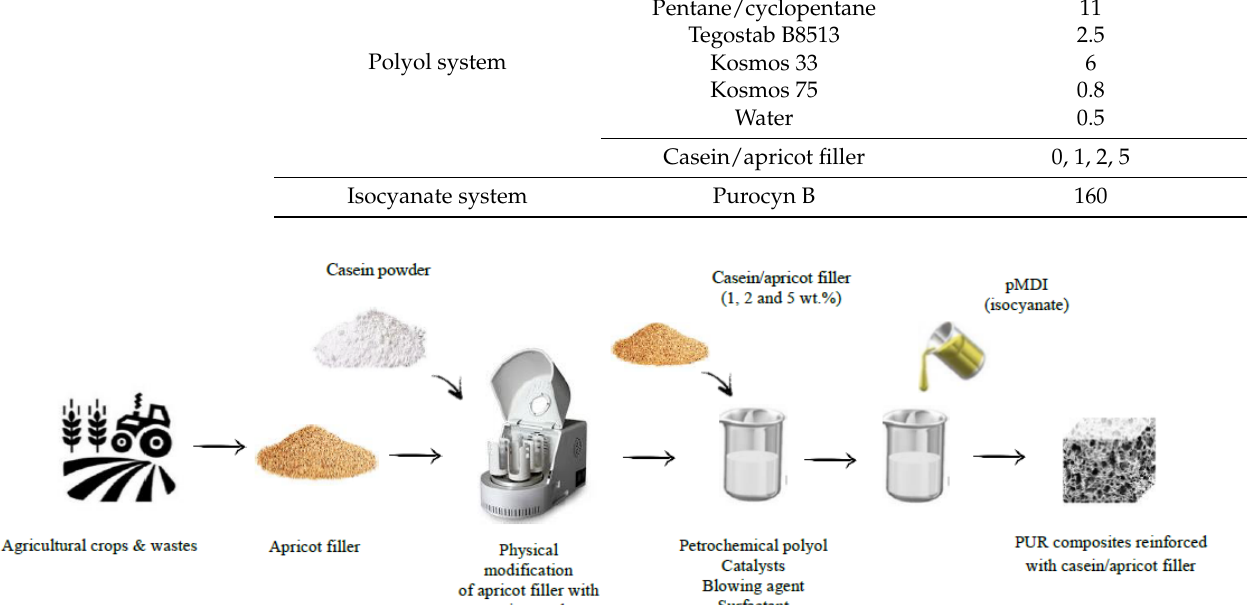
Figure 2. Schematic procedure of the synthesis of PUR composites reinforced with casein/apricot filler.